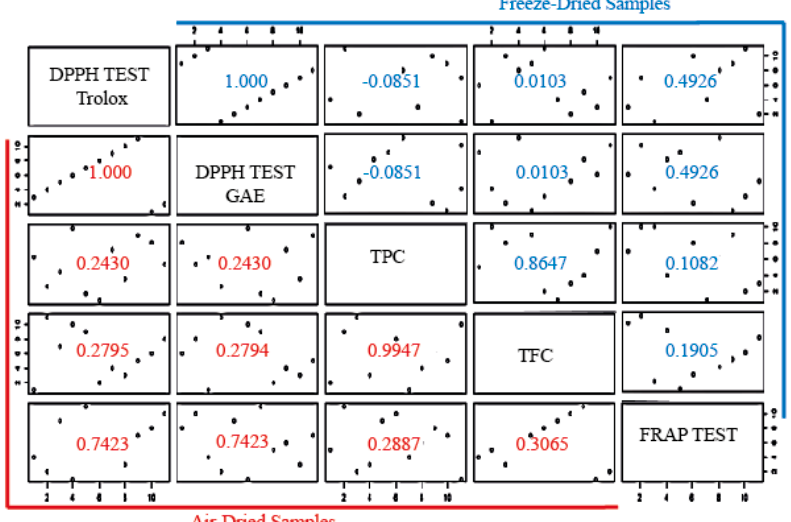
Figure 5. Scatter diagram with Pearson correlation coefficients for freeze- and air-dried samples’ performance in the antioxidant capacity DPPH test (gallic acid or Trolox equivalents) and FRAP test, TPC, and TFC.